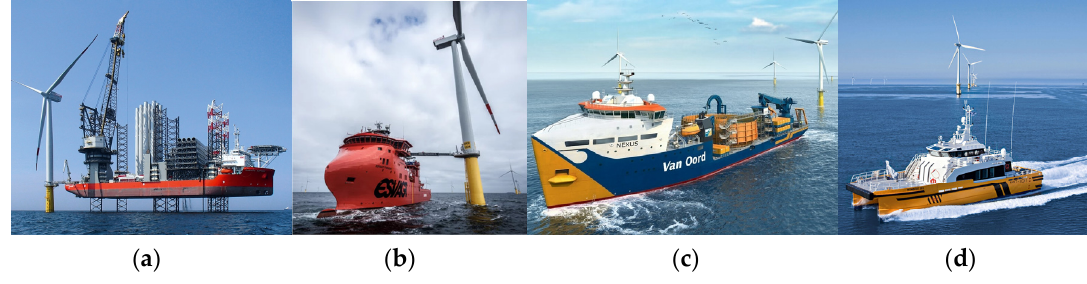
Figure 2. Sample photos of ships used at offshore wind farms: ( a ) Jack-Up Vessel (JUV) [23], ( b ) Service Operational Vessels (SOV) [24], ( c ) Cable Laying Vessel (CLV) [25], ( d ) Crew Transfer Vessel (CTV) [26].